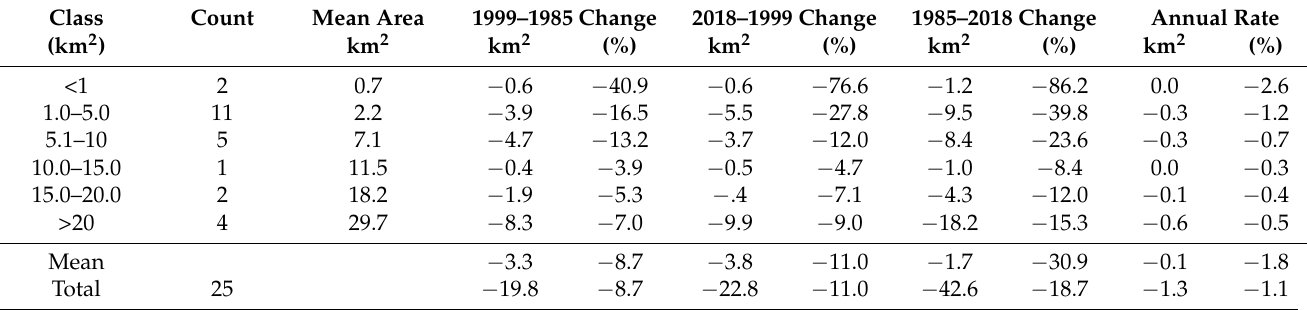
Table 4. Changes in class sizes of the glaciers between 1985 and